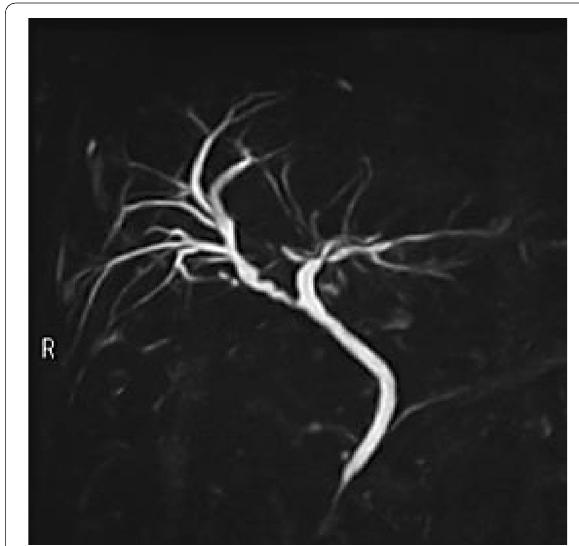
Fig. 3 Postoperative imaging of the biliary tract. A representative image of MRCP performed 9 months postoperatively showing the remnant cystic duct functioning as the right hepatic